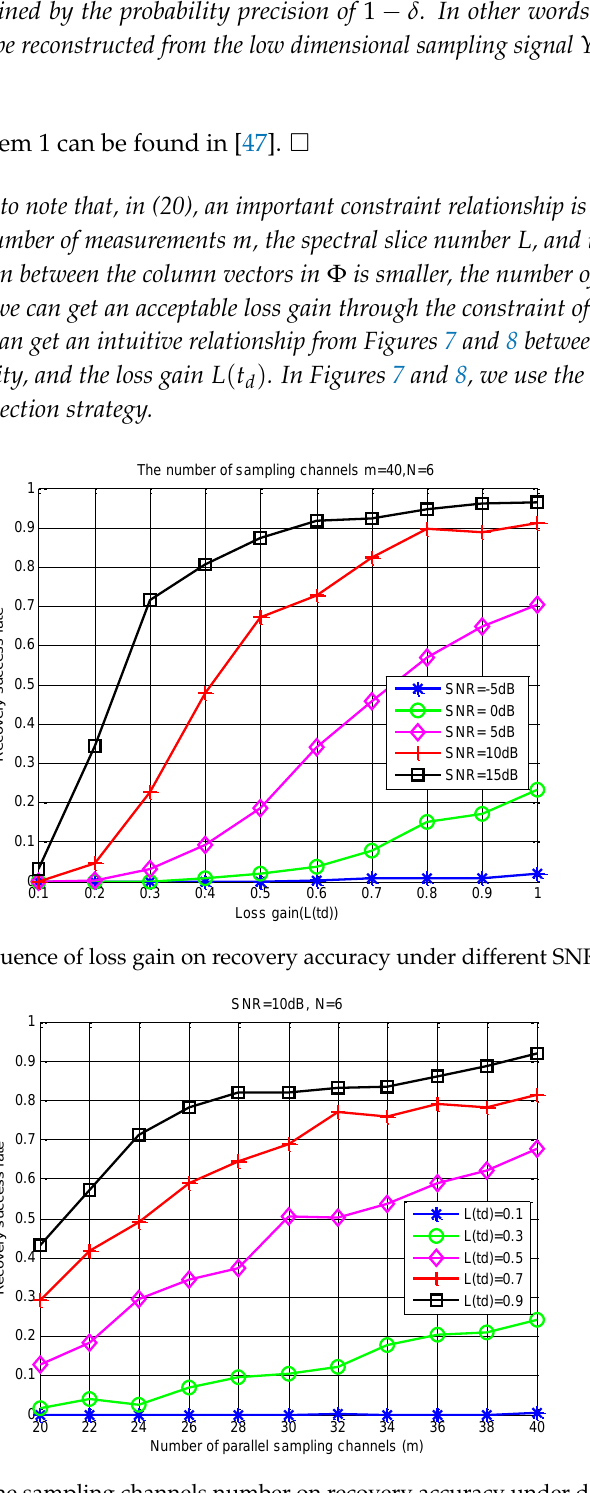
Table 2. The comparison of the extraction and reconstruction ability. Parameters